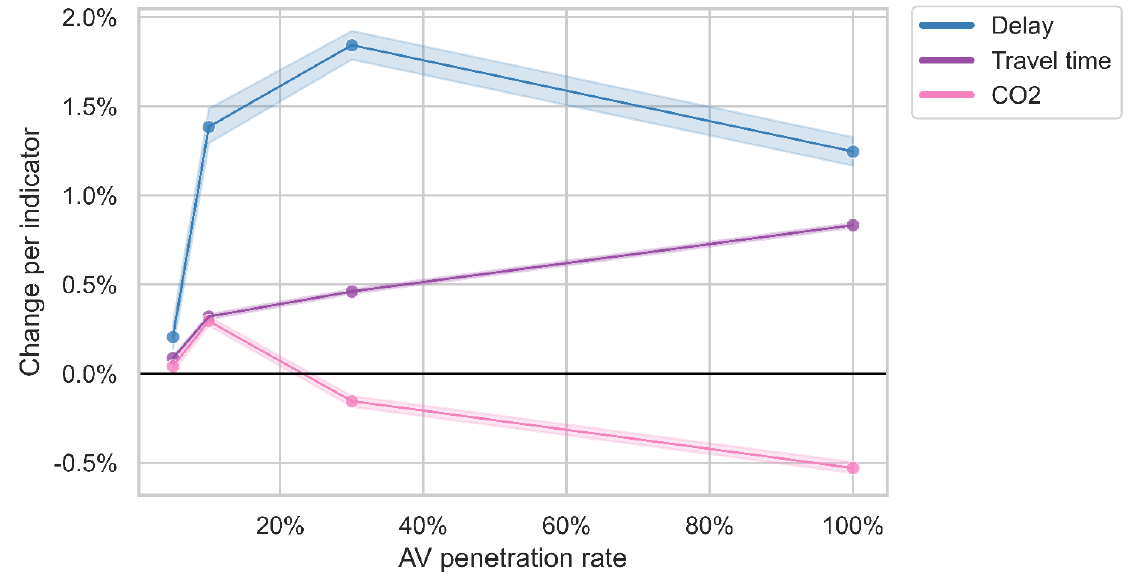
Figure 9. Scaled-up results with relative changes in travel time, delay and CO 2 emissions at AV penetration rates of 5%, 10%, 30% and 100% among passenger cars compared to the baseline, with 95% confidence intervals based on the bootstrapping method. Mean change in indicators (per VKT) for each AV penetration rate among passenger cars compared to the baseline with 95% confidence intervals based on the bootstrapping